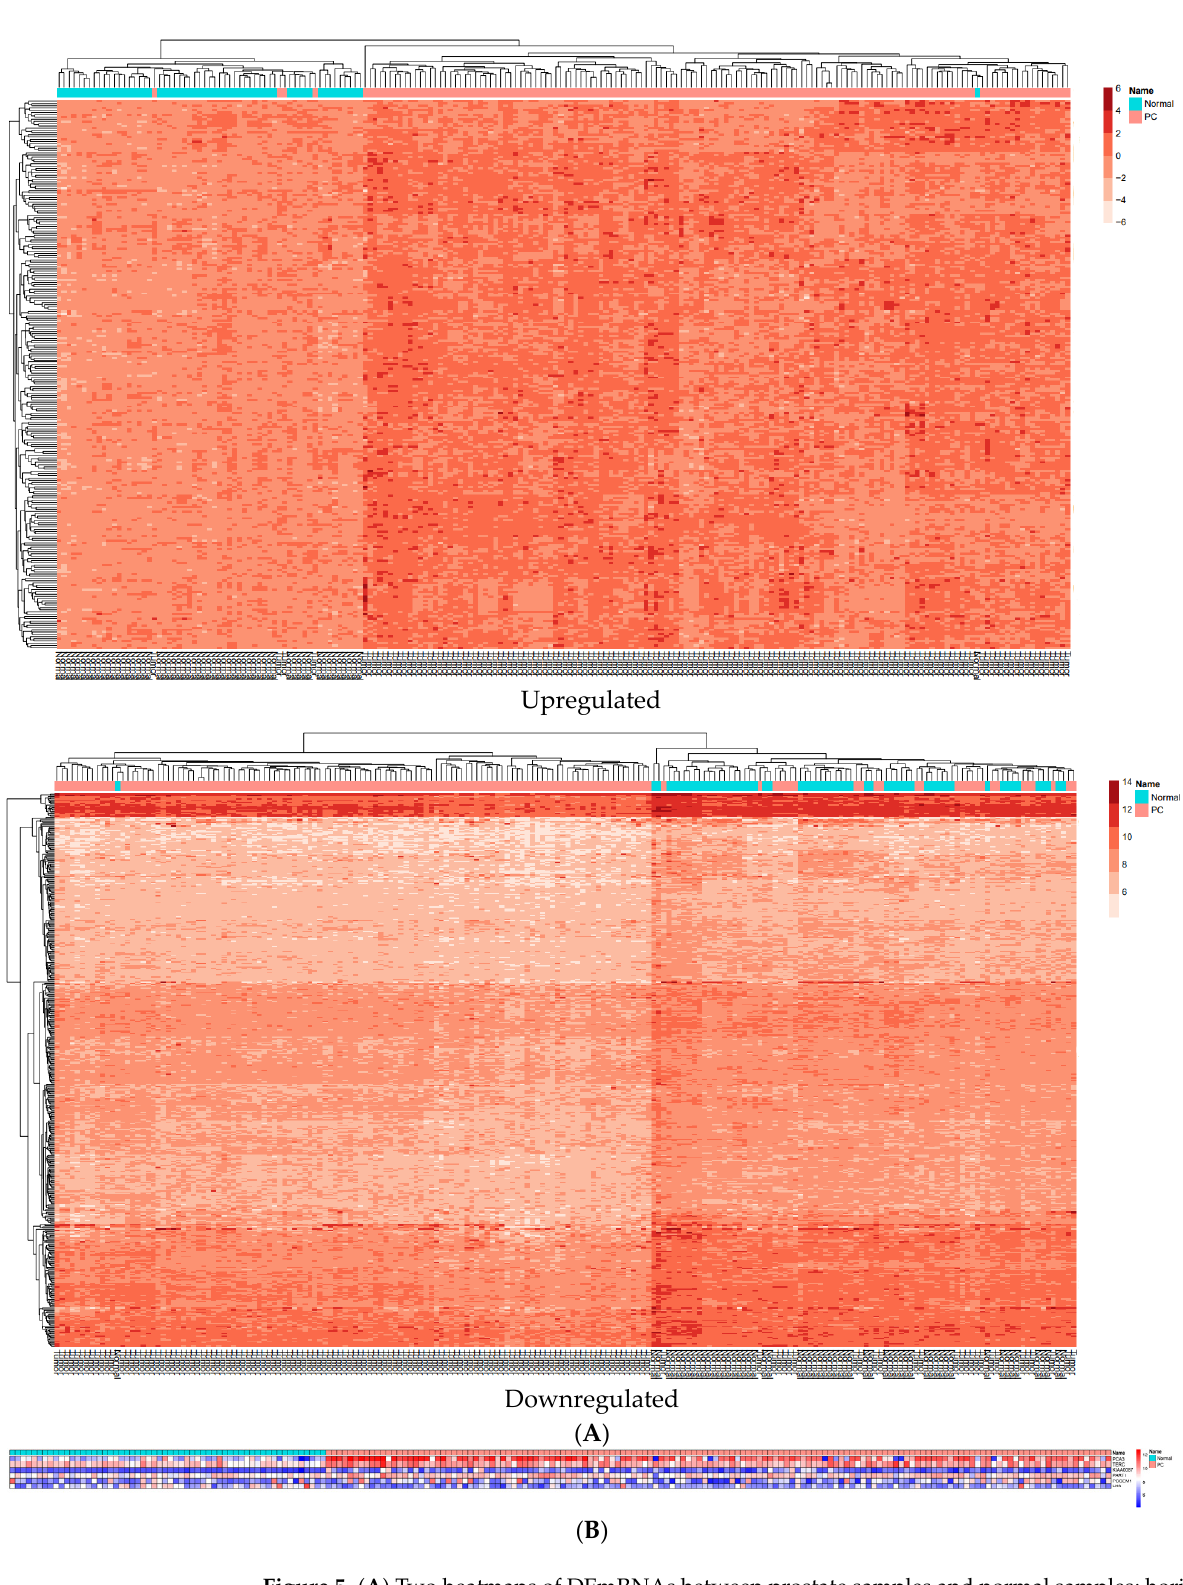
Figure 4. The volcano plot of DElncRNAs, mRNAs DEmRNAs ( A ) and DEmiRNAs ( B ); horizontal axis, log 2 (FC); vertical axis, − log 10 (adjusted p value).